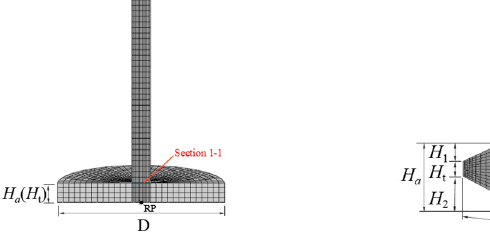
Figure 3. Sign convention and definition of terminology.